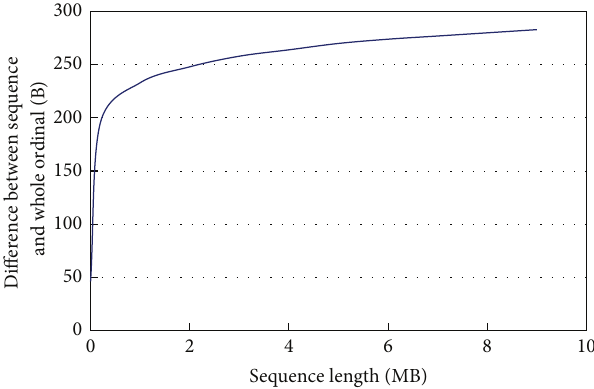
Figure 5: Difference of sequence length and whole ordinal